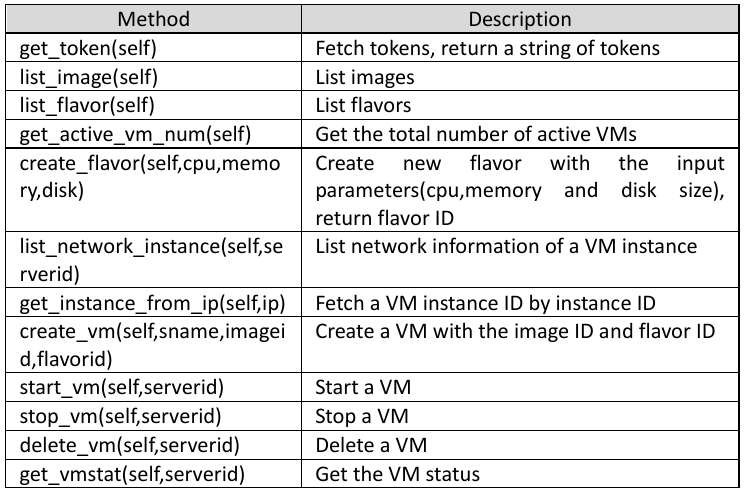
Table 3. A set of methods of